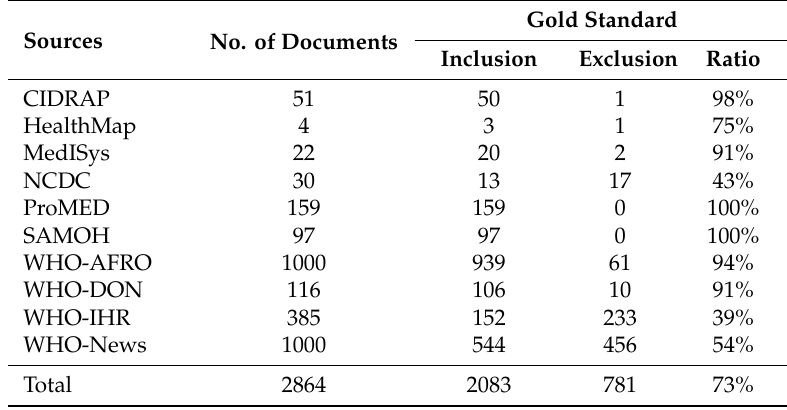
Table 2. Gold standard for identifying infectious disease